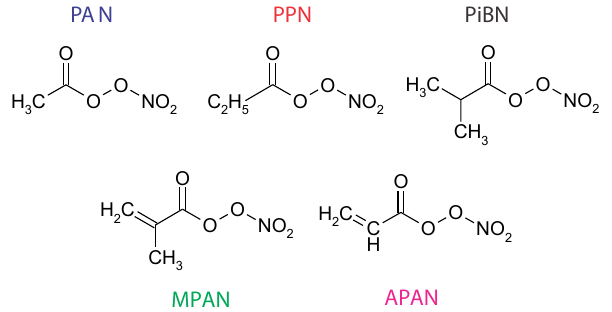
Figure 1. Molecular structures of common peroxycarboxylic nitric anhydrides. PAN = peroxyacetic, PPN = peroxypropionic, PiBN = peroxyisobutanoic, MPAN = peroxymethacryloyl, and APAN = peroxyacryloyl nitric